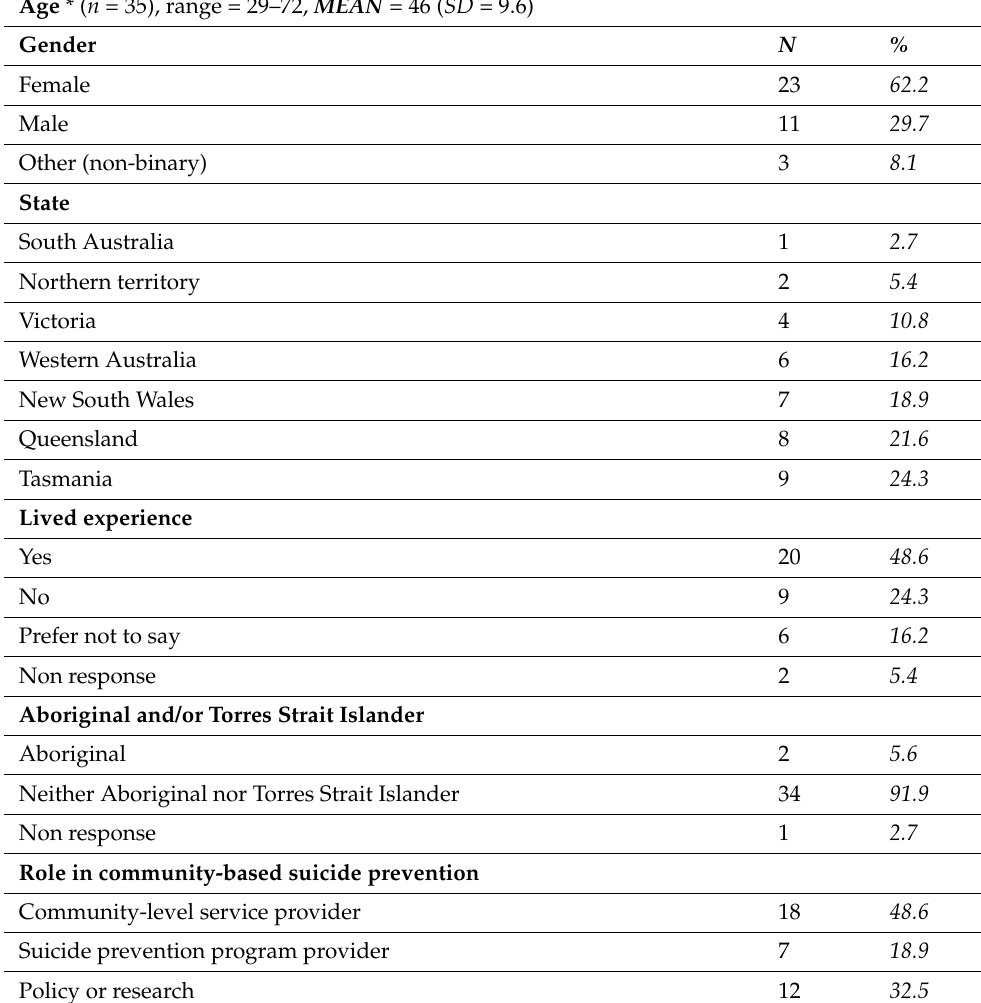
Table 1. Participant demographic